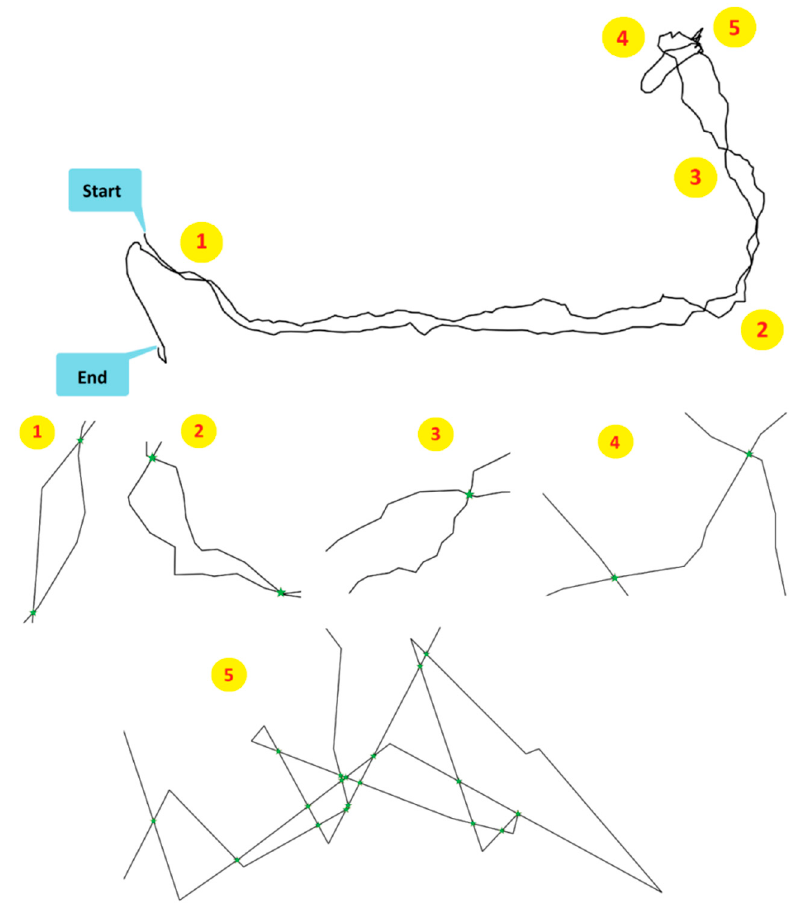
Figure 18. Self-intersecting points of a given trajectory.